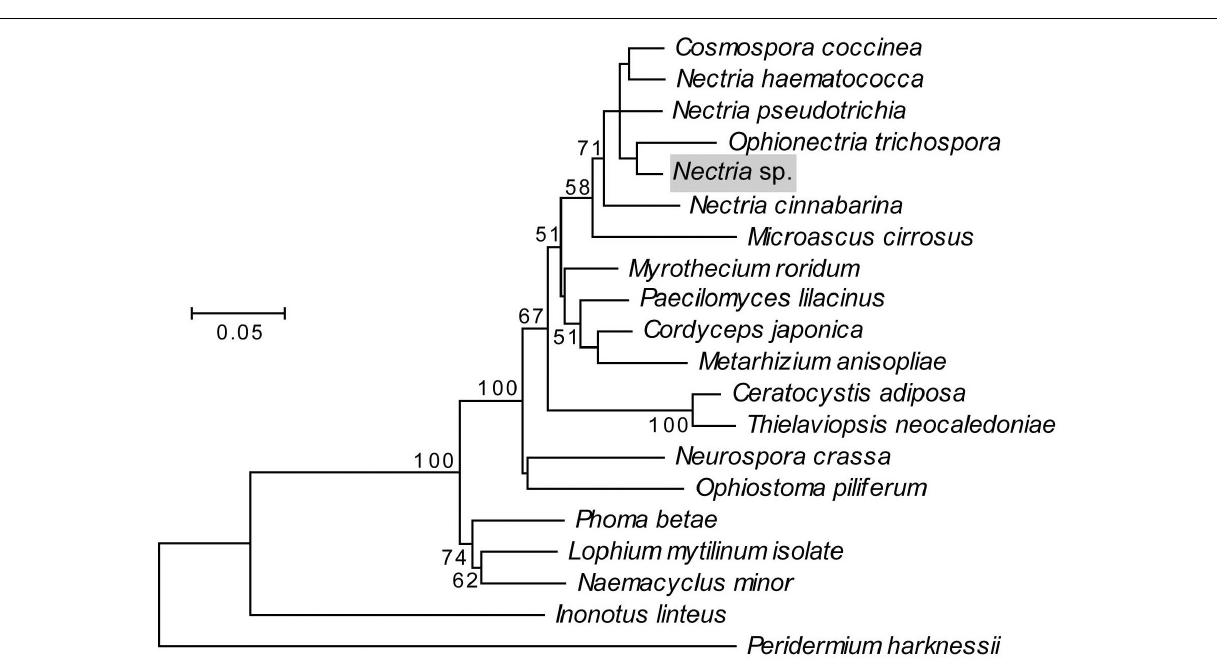
FIGURE 4 | Maximum likelihood phylogeny of the fungal antagonist, highlighted in gray, constructed using concatenated 18S rRNA and EF- α genes in MEGA5. The Tamura-Nei substitution model was used with discrete gamma-distributed rate variation having 5 categories and a proportion of invariable sites, selected by MEGA5 as best fitting the data. The percent node conservation > 50% in 500 bootstrap replicates is indicated, and the scale bar indicates the number of substitutions per site. MEGA5’s initial heuristic tree search was applied using an initial neighbor-joining tree of pairwise distances estimated using the Maximum Composite Likelihood method. Accession numbers for 18S sequences in order of phylogeny top to bottom: AY489702.1, AY489697.1, AY342011.1, NG_013128.1, Nectria sp., AB003949.1, M89994.1, AY489676.1, AY526475.2, AY245669.1, AB027337.1, EU984263.1, FJ176288.1, AY046271.1, DQ471003.1, EU754079.1, DQ678030.1, FJ176812.1, GU461973.1, and AY665785.1. Accession numbers for EF- α sequences in order of phylogeny top to bottom: HM484515.1, AY489624.1, HM534878.1, AF543779.1, Nectria sp., AF543785.1, HM569658.1, AY489603.1, GU979990.1, DQ522330.1, AY445082.1, HM569644.1, HM569649.1, XM_959775.2, DQ677926.1, DQ471074.1, GU349075.1, FJ238400.1, GU461936, and DQ234567.